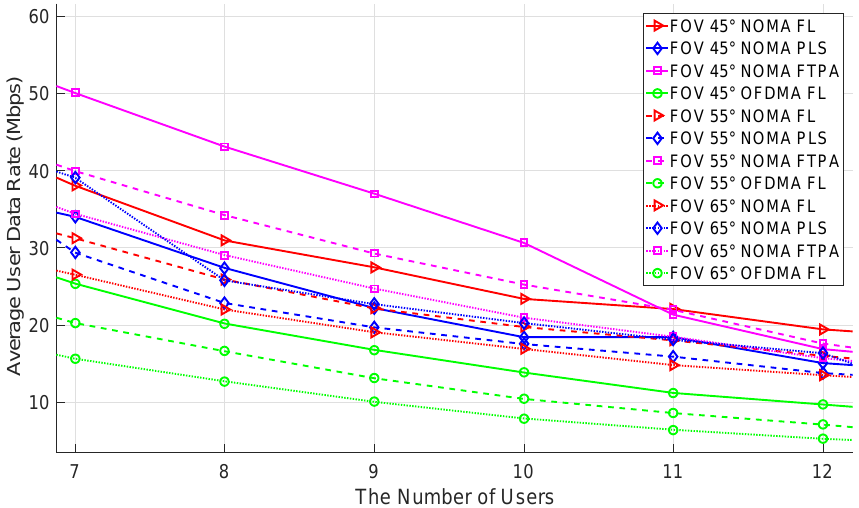
Figure 10. Comparisons of AUDR with varied field of views (FOV) and QoS expectations for 30